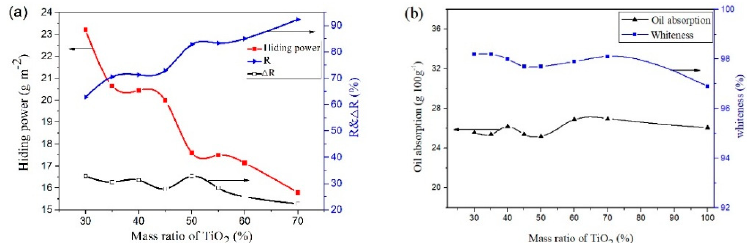
Figure 5. Pigment properties of CaCO 3 -TiO 2 composite particles with different mass ratios of TiO 2 . ( a ) Hiding power (R) and relative hiding power ( Δ R), ( b ) Oil absorption and whiteness.